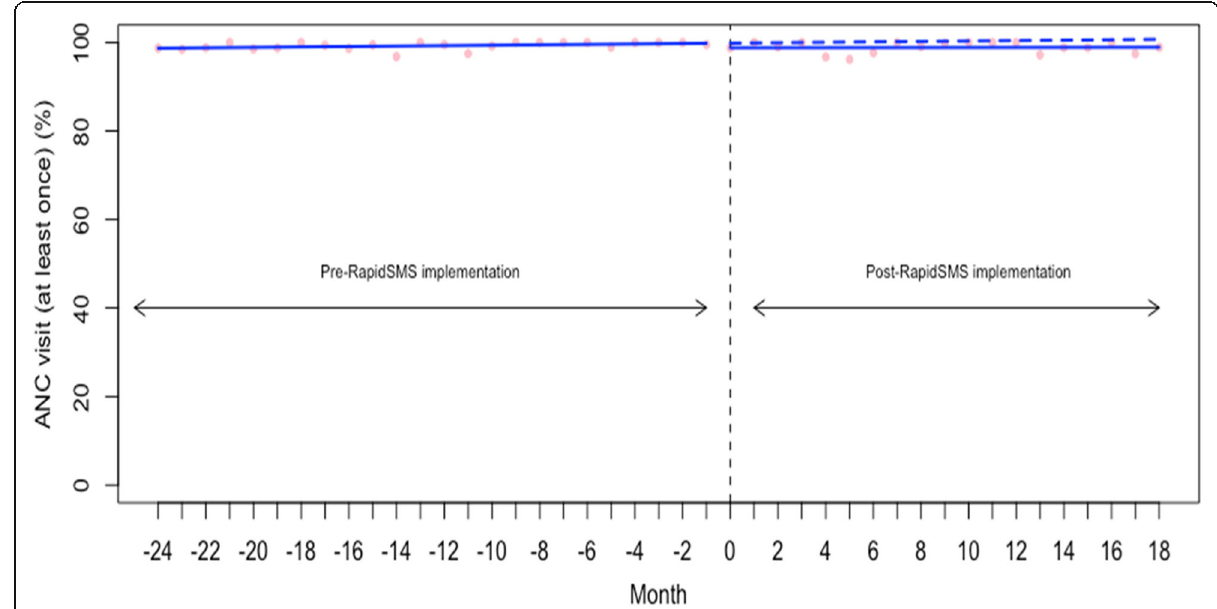
Fig. 1 Interrupted time series analysis of antenatal care (at least one visit) during pregnancy